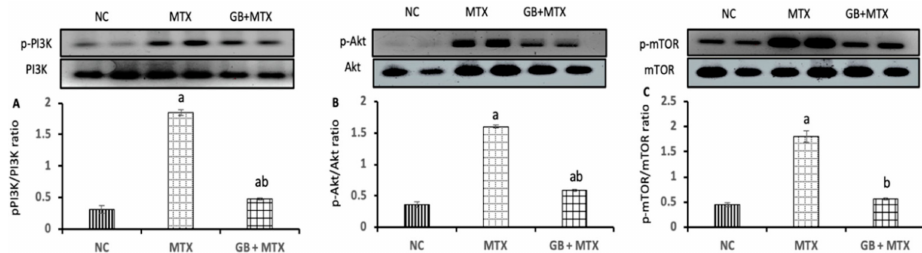
Figure 3. E ff ect of 20 mg / kg methotrexate (MTX, ip) only and when combined with 60 mg / kg Ginkgo biloba extract (GB, orally for 10 days) on the activity of phosphatidylinositol 3-kinase / protein kinase B / mammalian target of rapamycin (PI3k / Akt / mTOR) signaling pathway. The western blots bands of proteins and its relative expression p-PI3K / PI3k protein ( A ); p-Akt / Akt protein ( B ); and p-mTOR / mTOR protein ( C ) in renal tissue in all studied groups. a p < 0.05 versus NC group. b p < 0.05 versus MTX group.